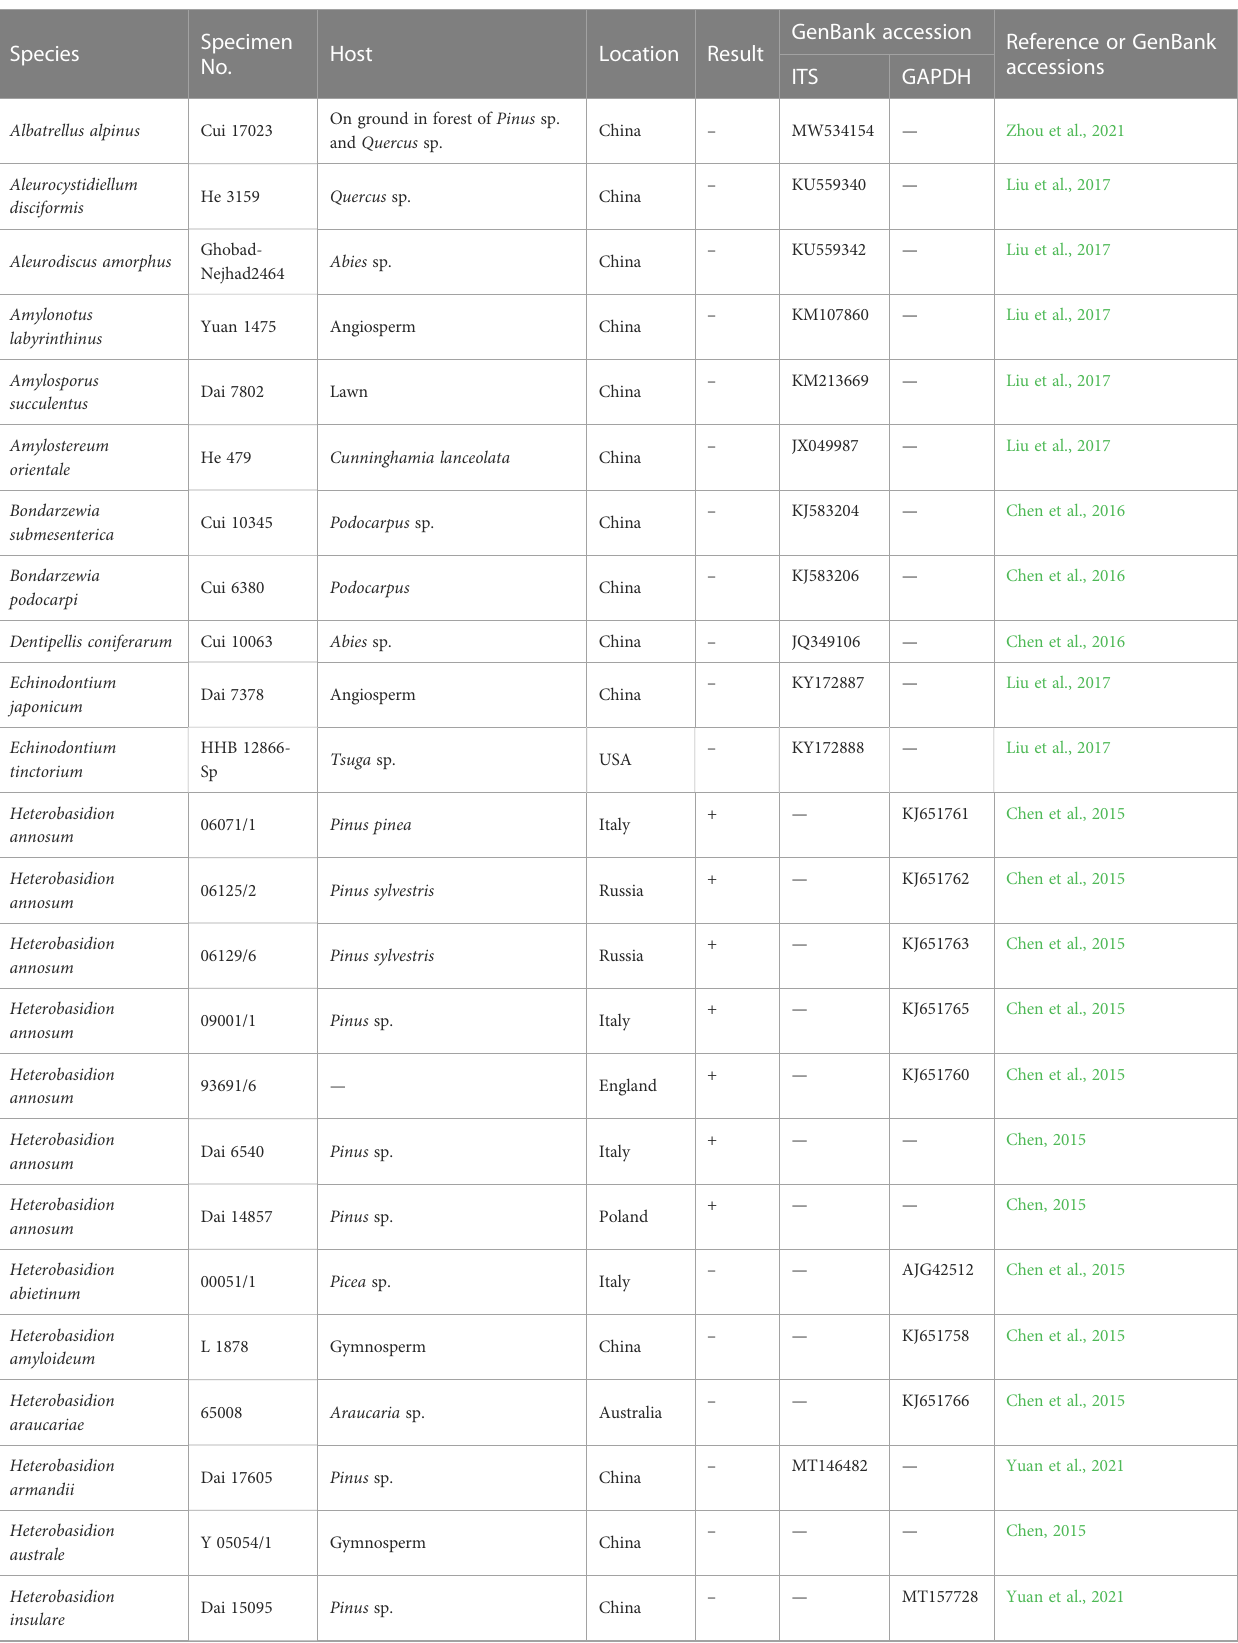
TABLE 1 Fungal isolates and basidiomata used in this